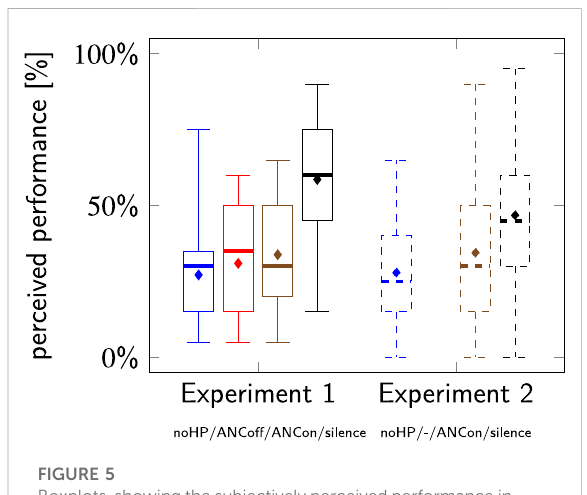
FIGURE 5 Boxplots, showing the subjectively perceived performance in the serial recall test.